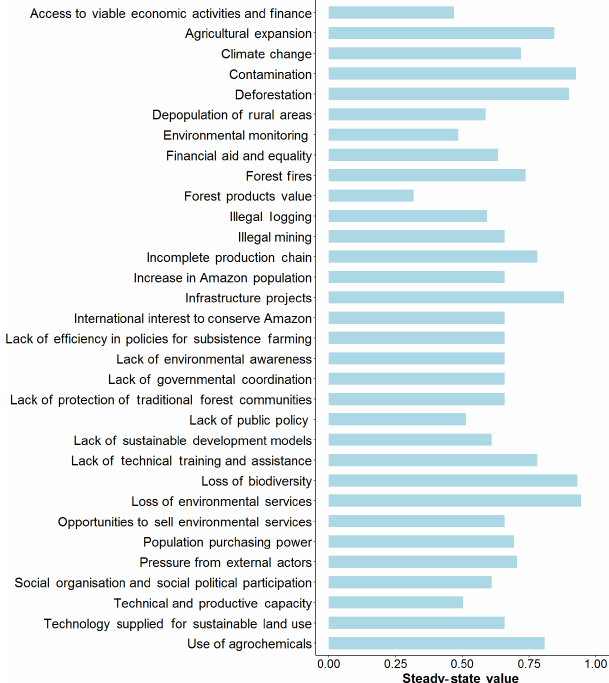
Figure 7. Component values for the Tapajós case study FCM un- der steady-state “baseline” conditions. Values close to 0 represent a strong decrease in the component, whilst values closer to 1 repre- sent a strong